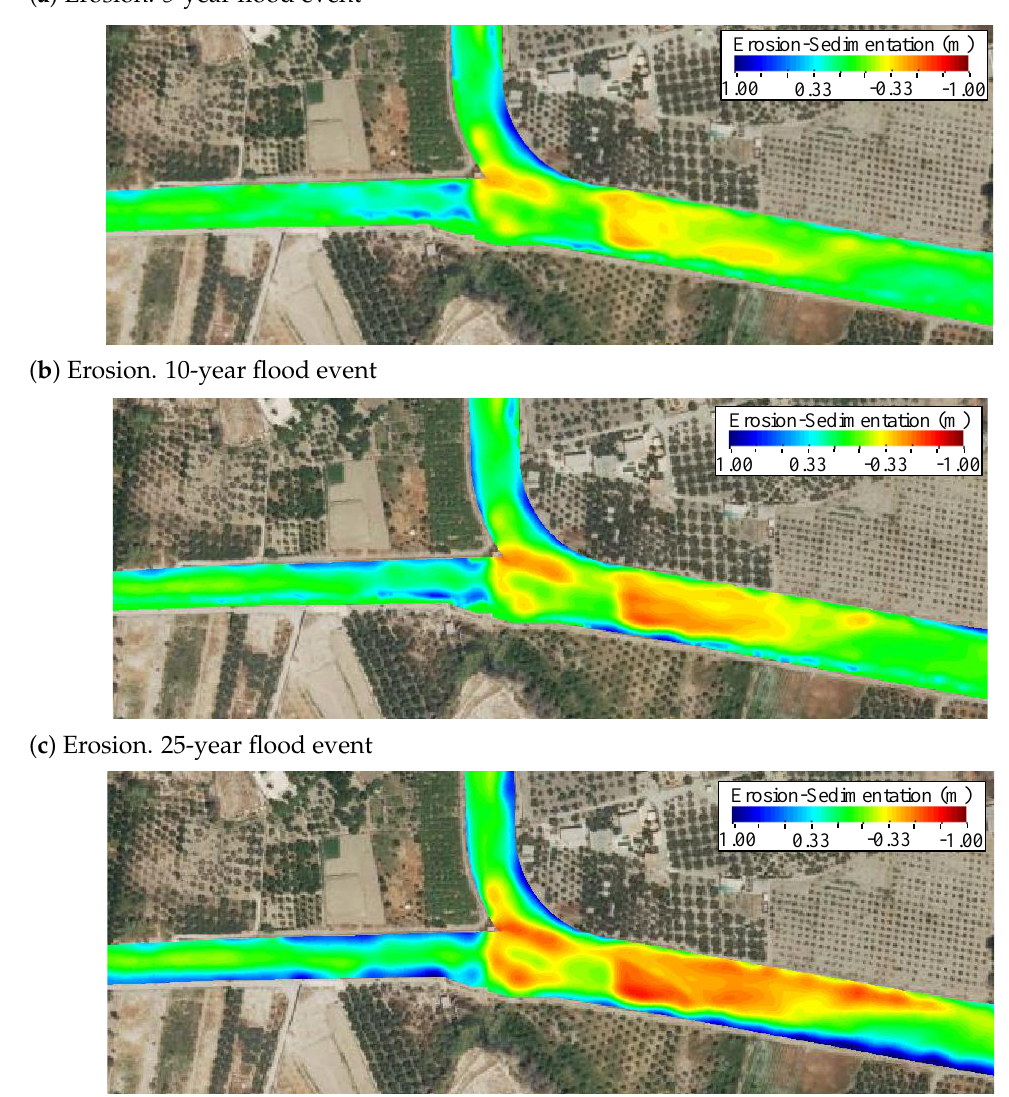
Figure 10. Effect of flood return period on the erosion pattern. We plot the erosion patterns for three flood events with return periods: ( a ) T = 5 years, ( b ) T = 10 years, ( c ) T = 25 years. Erosion is positive and sedimentation